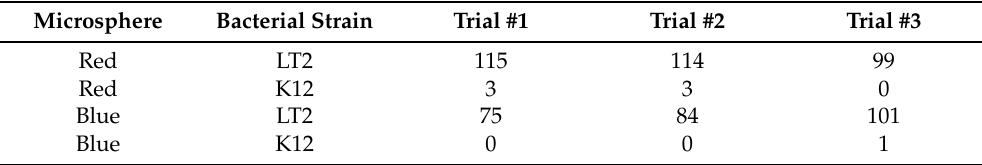
Table 2. Red functionalized microspheres (RFM) tested with target bacteria ( Salmonella LT2) and non- target bacteria ( E.coli K12). Blue functionalized microspheres tested with target bacteria ( Salmonella LT2) and non-target bacteria ( E.coli